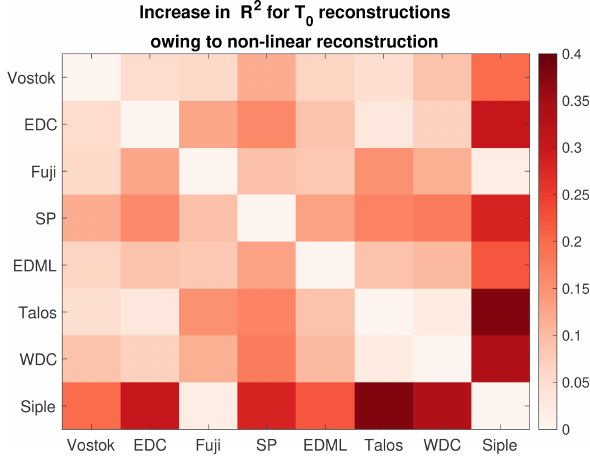
Figure A22. The increase in R 2 (shared variance) of the nonlin- ear reconstructions of T 0 for all sites over the linear reconstructions (linearized around Holocene conditions). All records are ordered by their approximate modern surface